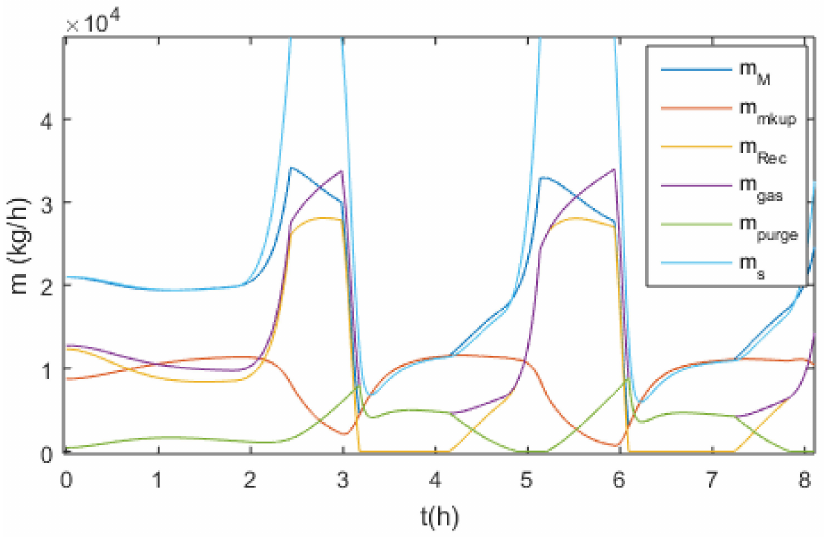
Figure 24. Mass flowrates after +50% of the inlet catalyst rate with Model 1. The consideration of a maximum recycle rate capacity, included in Model 2, eliminates this effect, as can be seen in Figure